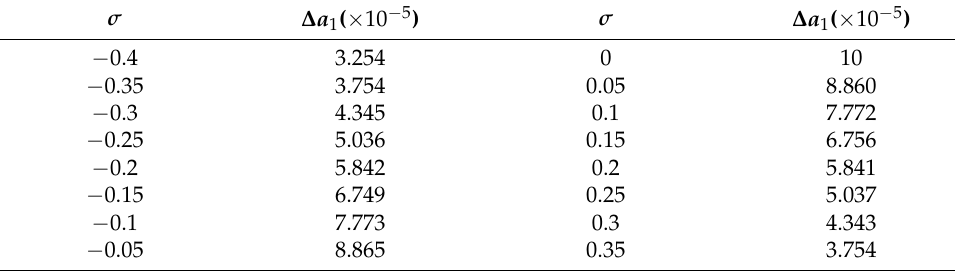
σ on modal amplitude variation.